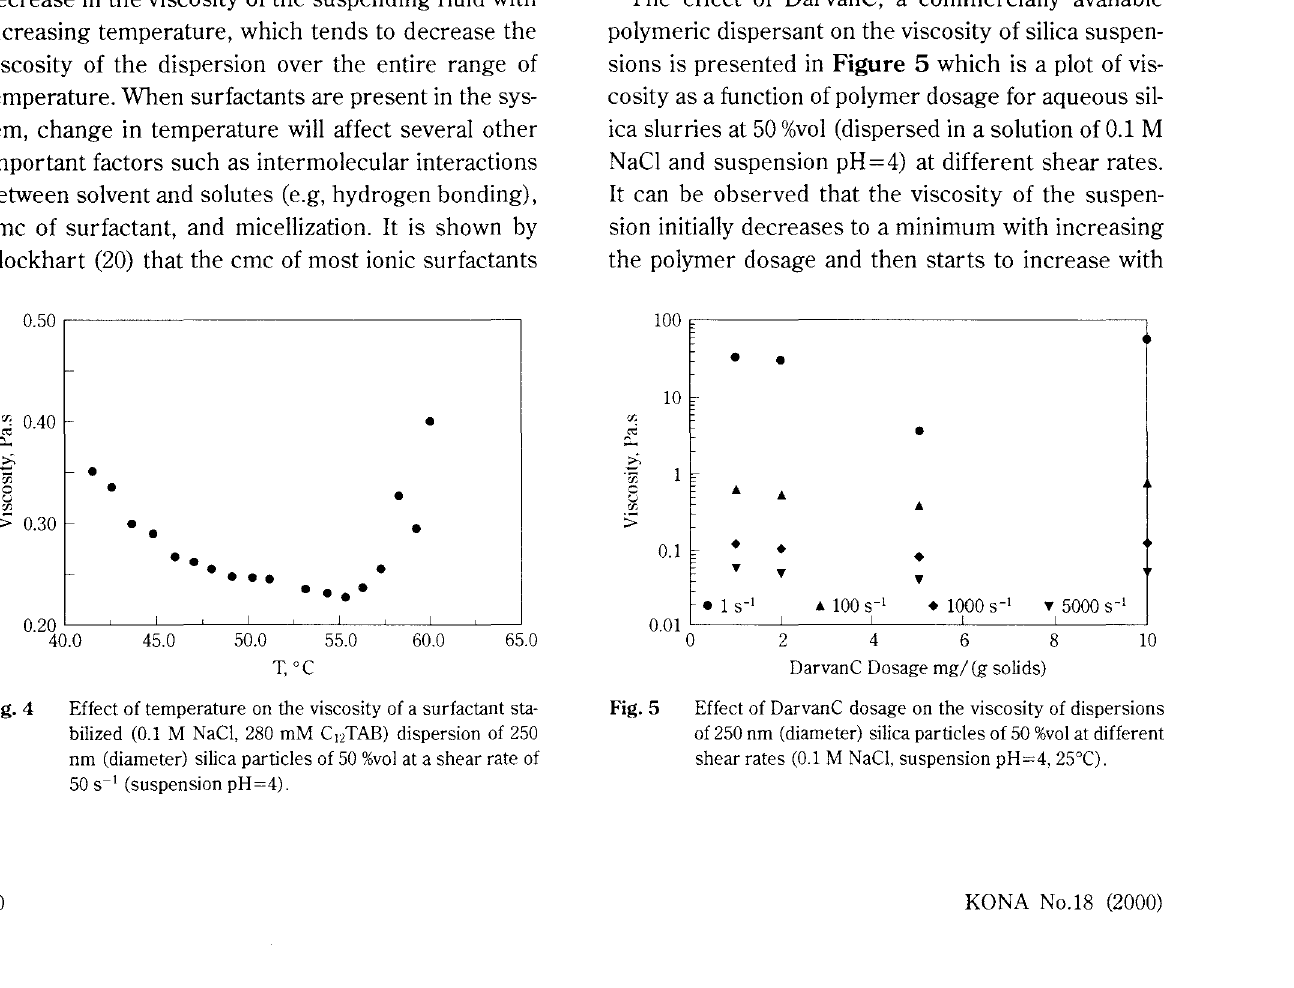
Effect of DarvanC dosage on the viscosity of dispersions of 250 nm (diameter) silica particles of 50 %vol at different shear rates (0.1 M NaCI, suspension pH=4,